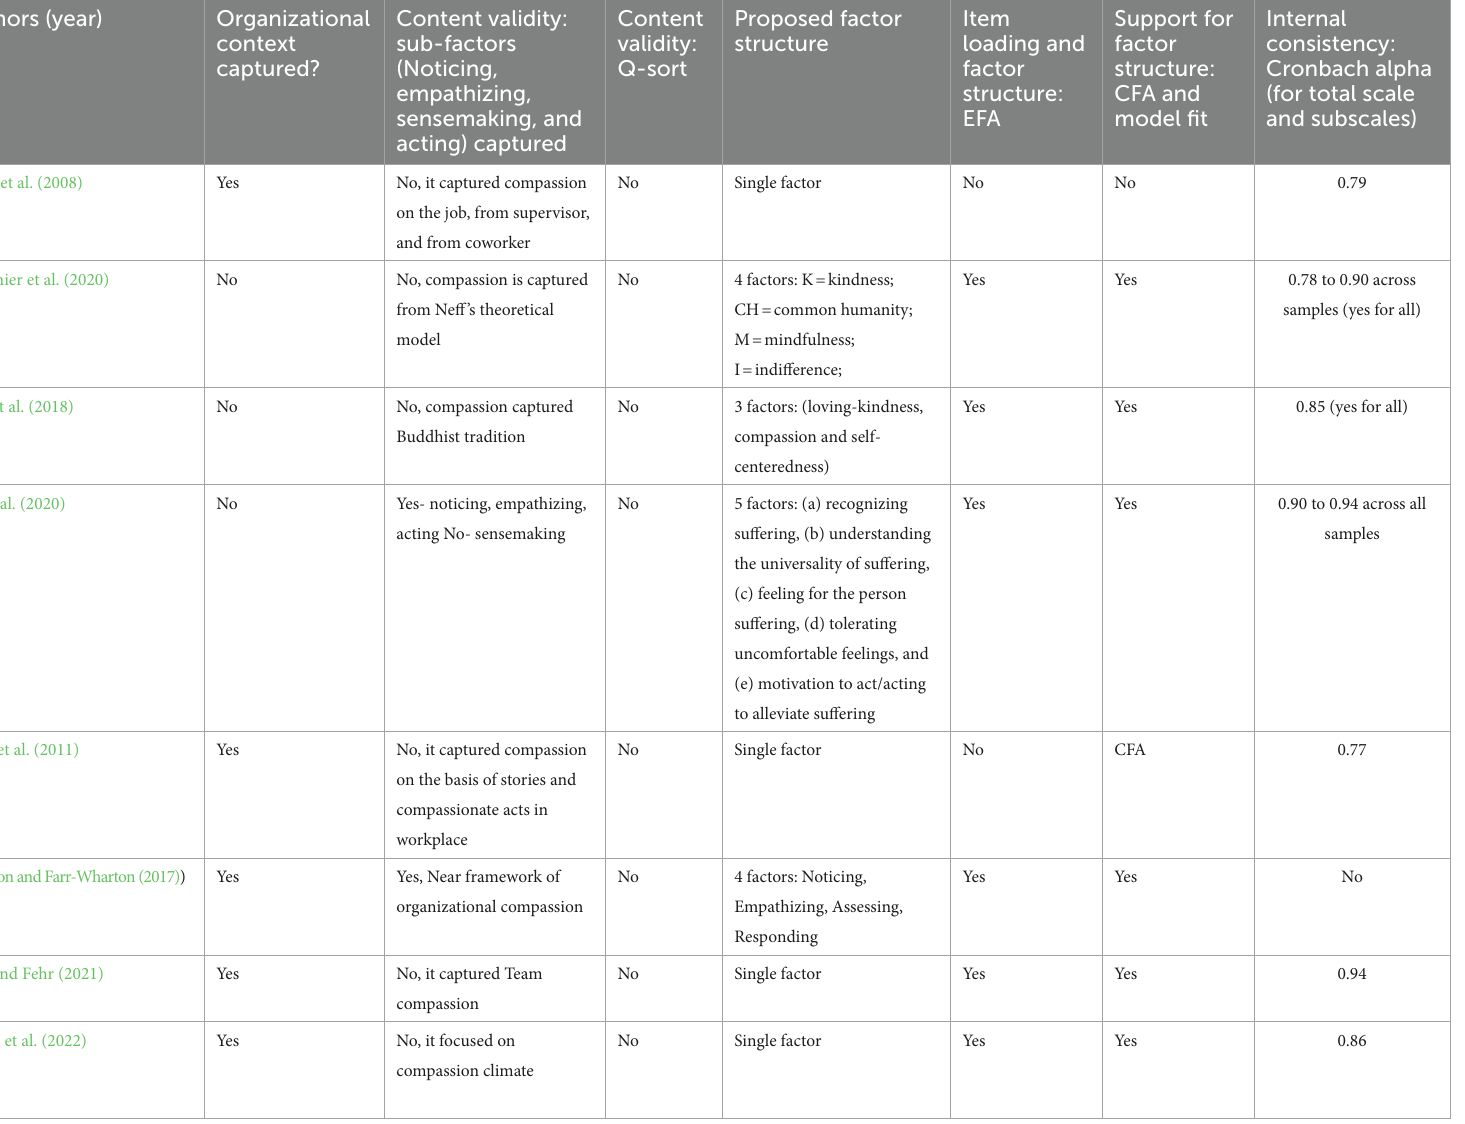
TABLE 1 Psychometric properties of measures of compassion and organizational compassion. Sr.